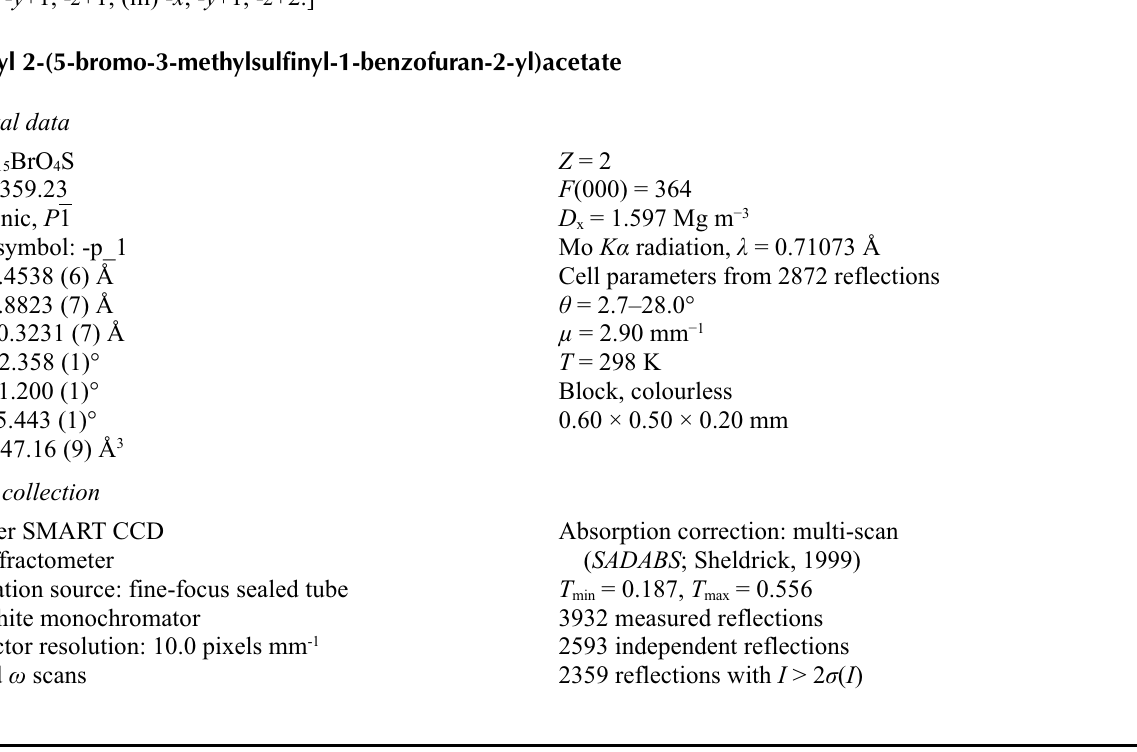
Intermolecular C—H···O hydrogen bonds (dotted lines) in the title compound. [Symmetry codes: (i) - x +1, - y +1, - z +2; (ii) - x +1, - y +1, - z +1; (iii) - x , - y +1, - z